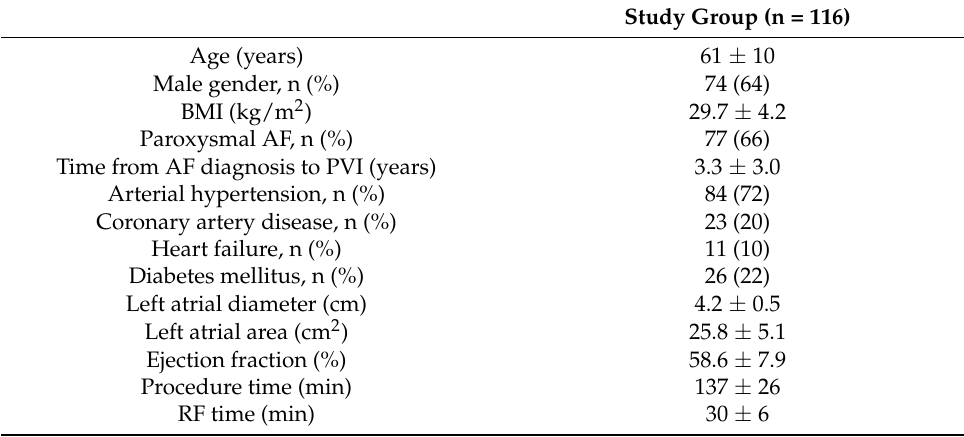
Table 1. Demographic and clinical characteristics.